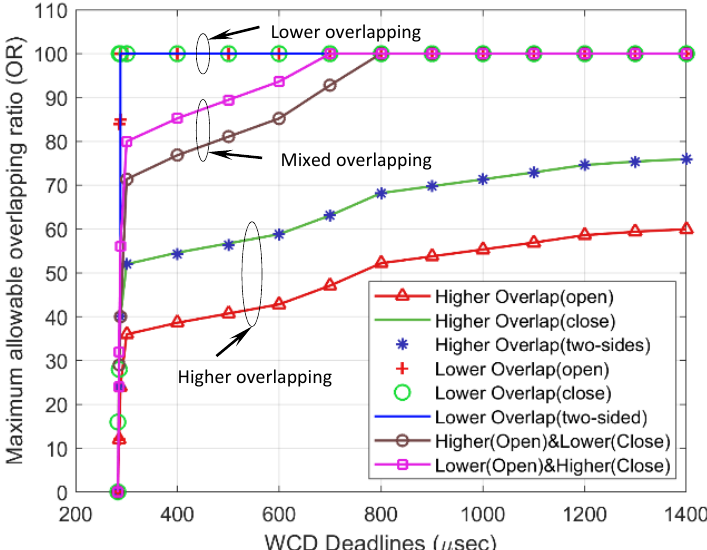
Figure 16. Maximum allowable overlapping ratio (OR) vs. guaranteed WCD deadlines under one-sided and two-sided overlapping conditions by lower-, higher-, and mixed-priority queues.